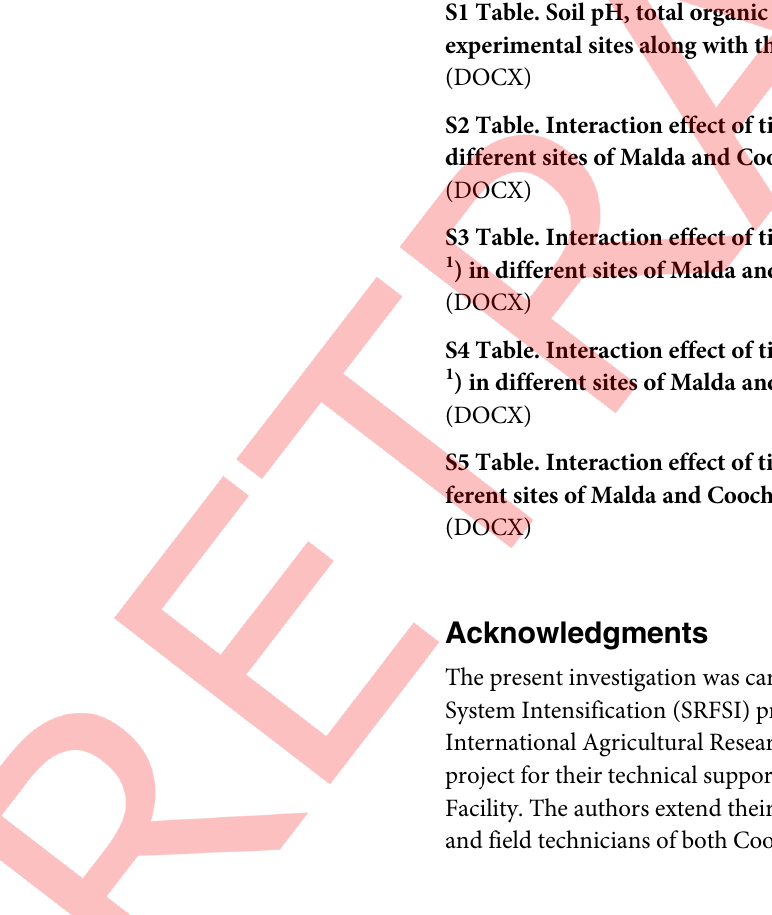
S1 Table. Soil pH, total organic C, total N, texture, and bulk density (0–20 cm) of the experimental sites along with the profile description and taxonomic name. S2 Table. Interaction effect of tillage, cropping system, and soil depth on TOC (g kg -1 ) in different sites of Malda and Coochbehar. S3 Table. Interaction effect of tillage, cropping system, and soil depth on LP1 carbon (g kg - 1 ) in different sites of Malda and Coochbehar. S4 Table. Interaction effect of tillage, cropping system, and soil depth on LP2 carbon (g kg - 1 ) in different sites of Malda and Coochbehar. S5 Table. Interaction effect of tillage, cropping system, and soil depth on RC (g kg -1 ) in dif- ferent sites of Malda and